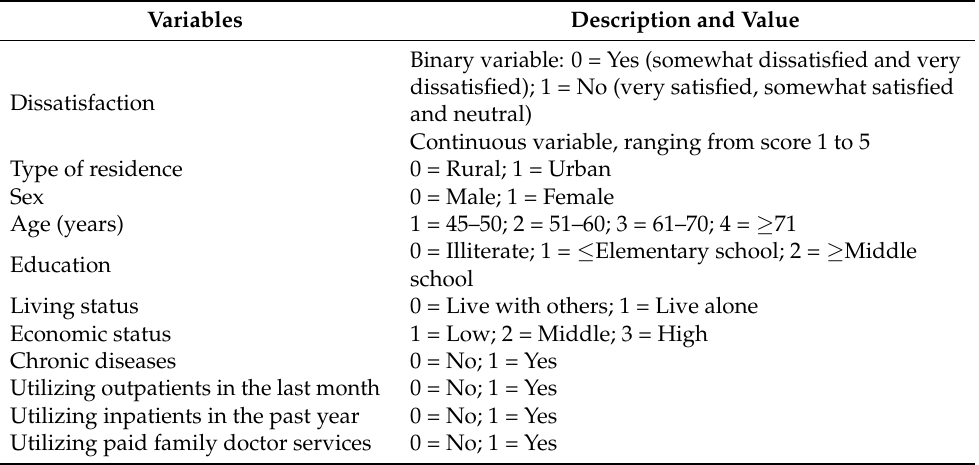
Table 1. Values assigned to the independent variables in multilevel modeling. Variables Description and